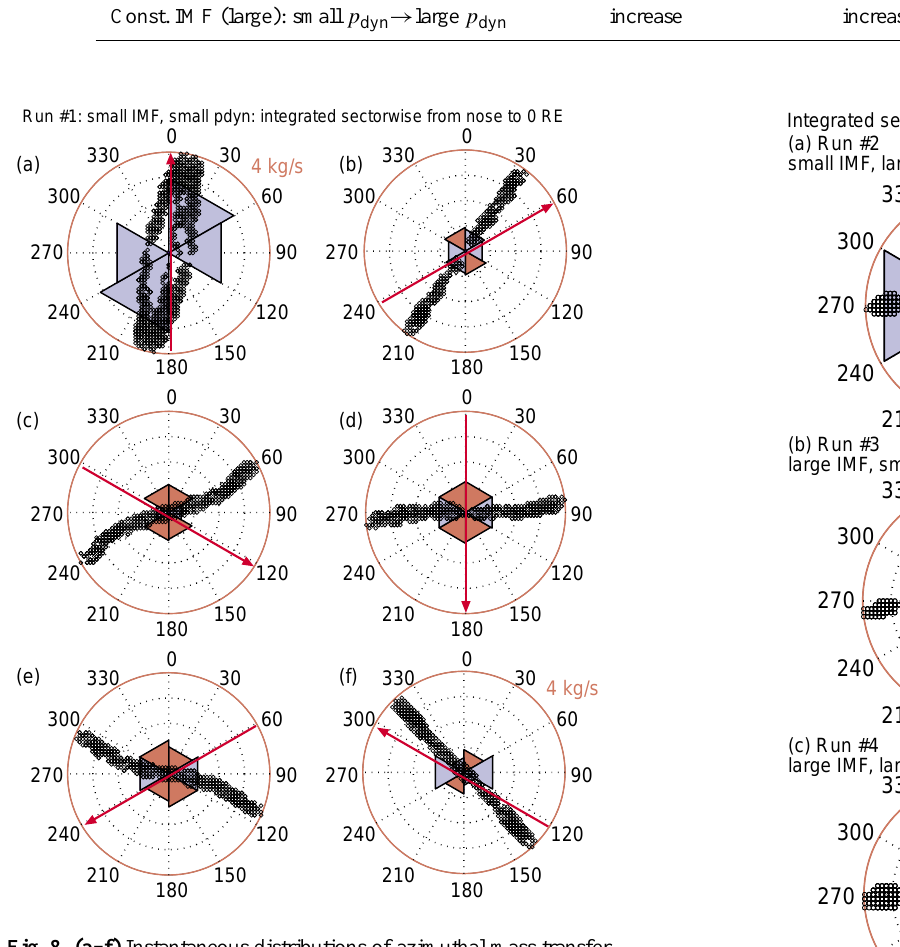
Fig. 8. (a–f) Instantaneous distributions of azimuthal mass transfer to dayside closed field for Run #1 at angles indicated by dashed ver- tical lines in Fig. 7. Blue (red) color indicates towards closed (out from closed) field mass transfer in sectors shown outside the outer circle. The sectors scale from 0kgs − 1 at the centre to 4kgs − 1 at the outer circle. The IMF clock angle direction is indicated by a red arrow, while black circles show the locations where the “four- field junction” condition holds; i.e., where reconnection is likely to occur. Note that the dayside black circles in panel (a) indicate sun- ward convection, not reconnection, which occurs behind the cusps (as deduced from the annihilation of magnetic energy).